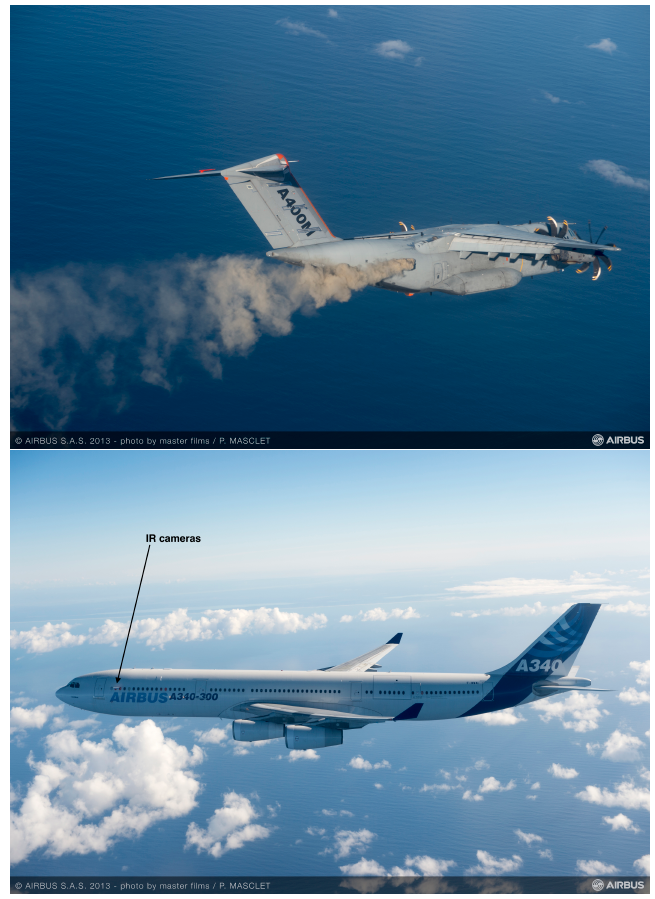
Figure 6. Top: AIRBUS A400 dispensing ash into the atmosphere. Bottom: AIRBUS A340 in flight with Figure 6. Top :AIRBUS A400 dispensing ash into the atmosphere. Bottom : AIRBUS A340 in flightwiththeIRcamerasmountedinapodandontotheforwardlefthandsideoftheaircraft. the IR cameras mounted in a pod and onto the forward lefthand side of the